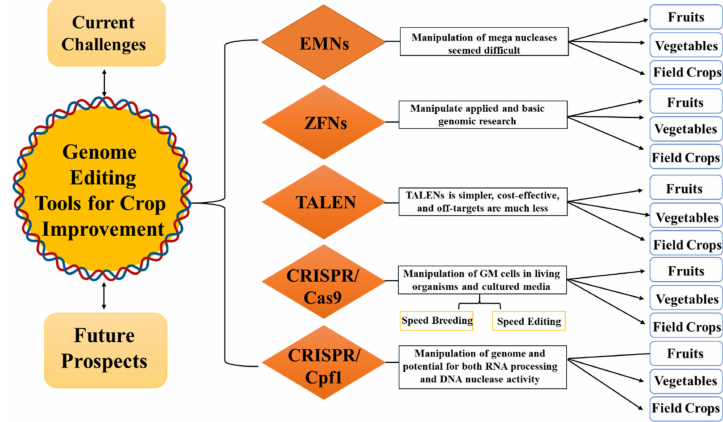
Figure 1. Overview of the di ff erent aspects covered in the present review related to genome editing in plants, such as its applications, challenges, and